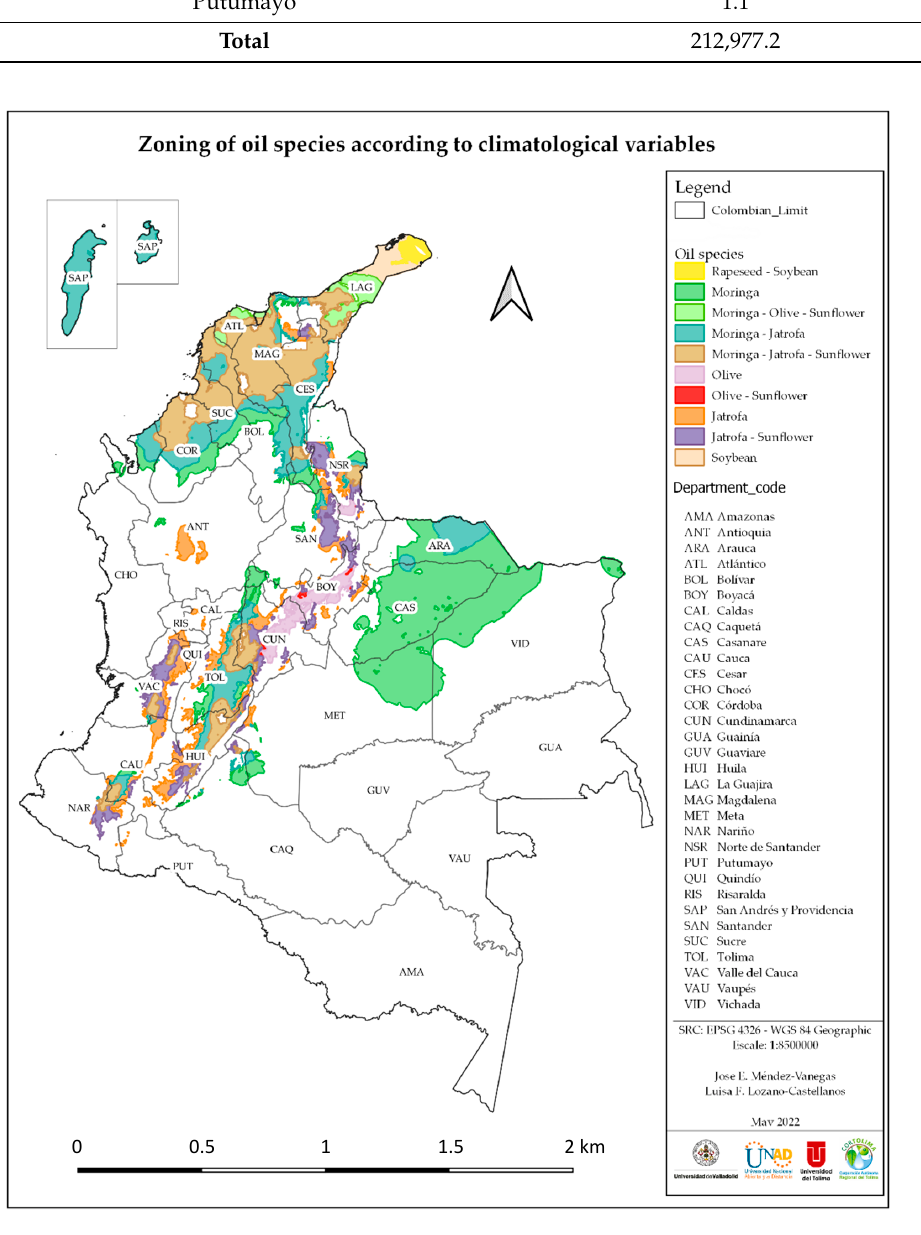
Figure 4. Zoning of oil species according to climatological variables. Table 3. Departmental area to produce oil species.